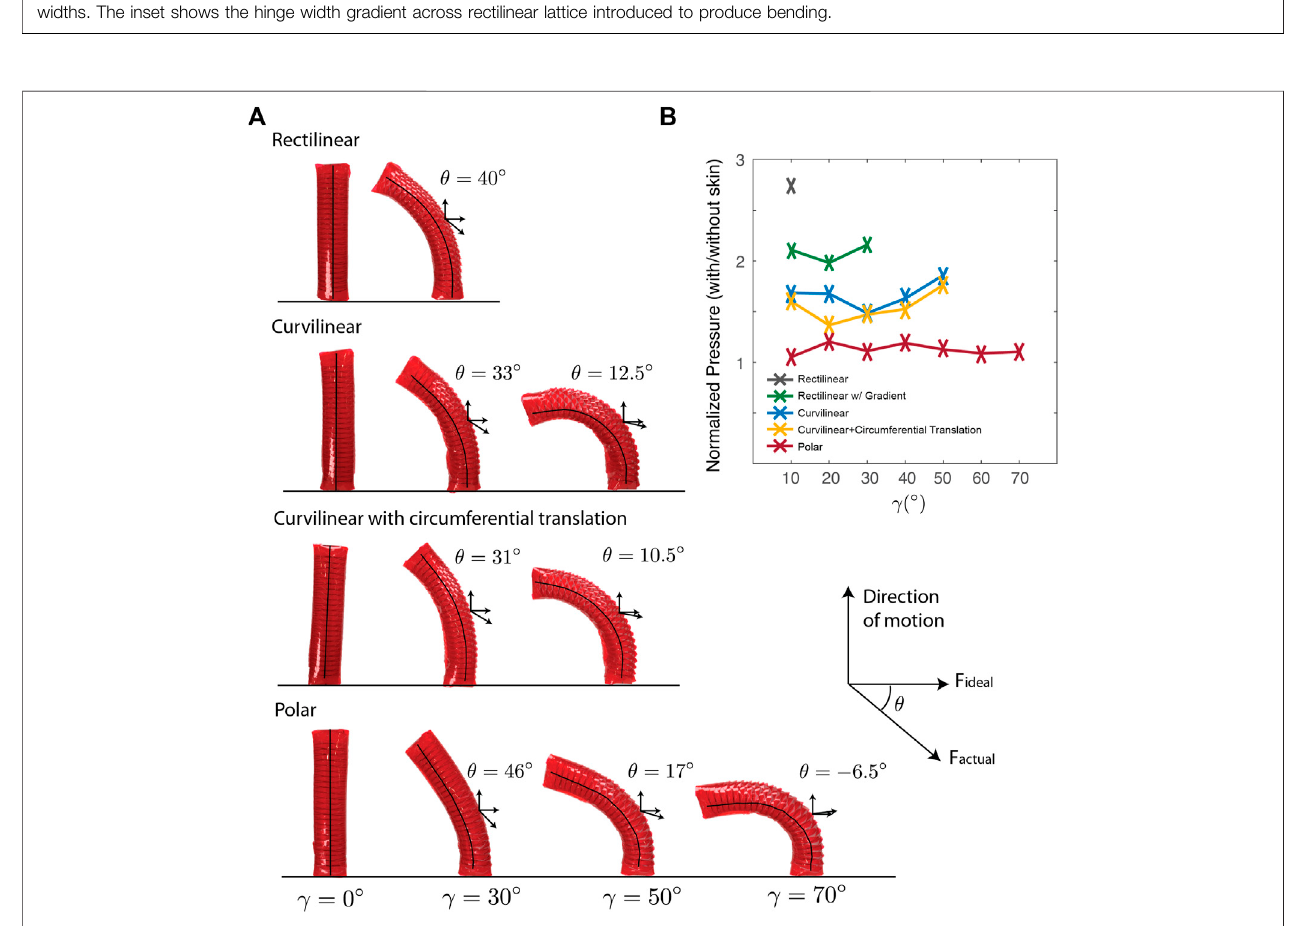
Frontiers in Robotics and AI |